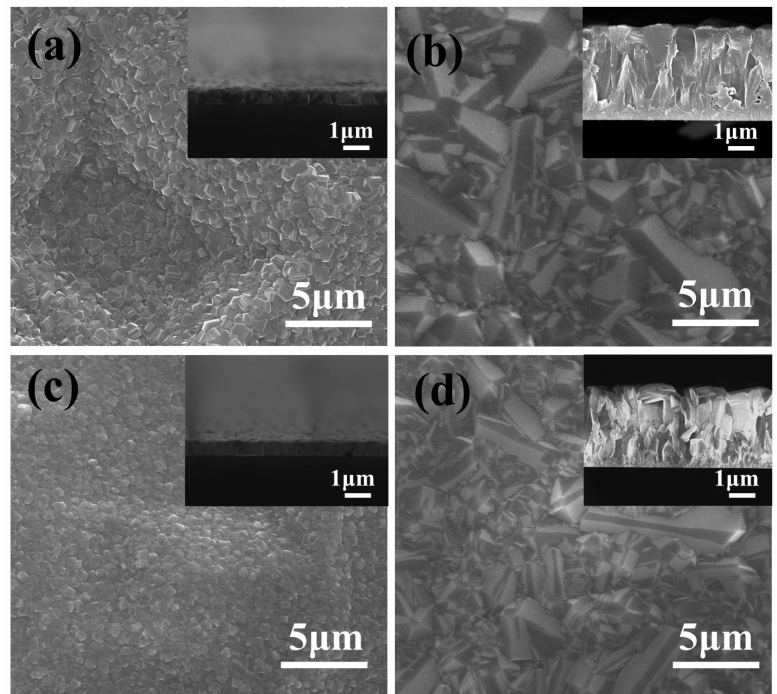
Figure 1. SEM images of BDD films with various deposition time and boron doping level: ( a ) 1 h with 0.1 B 2 H 6 ; ( b ) 4 h with 0.1 B 2 H 6 ; ( c ) 1 h with 0.4 B 2 H 6 ; ( d ) 4 h with 0.4 B 2 H 6 . The inset is the corresponding